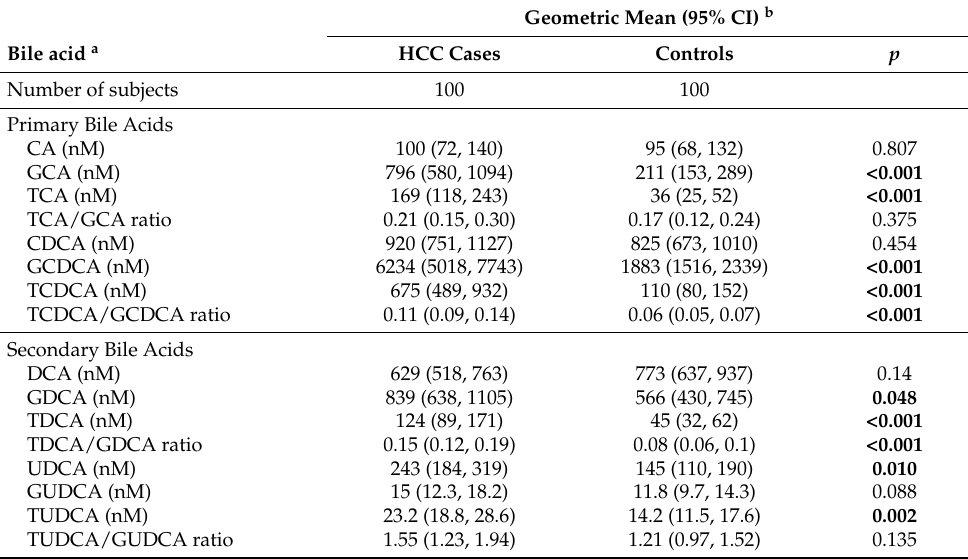
Table 4. Geometric means of free and conjugated bile acids and the molar ratios of taurine-over glycine-conjugated bile acids in hepatocellular carcinoma (HCC) cases and controls, The Singapore Chinese Health Study.